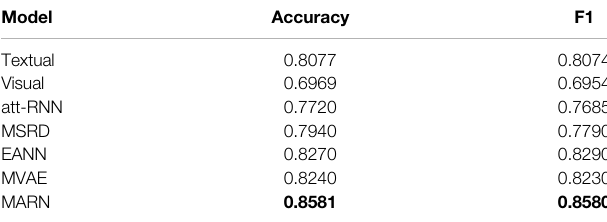
TABLE 3 | Results of different baseline models on a dataset. Model